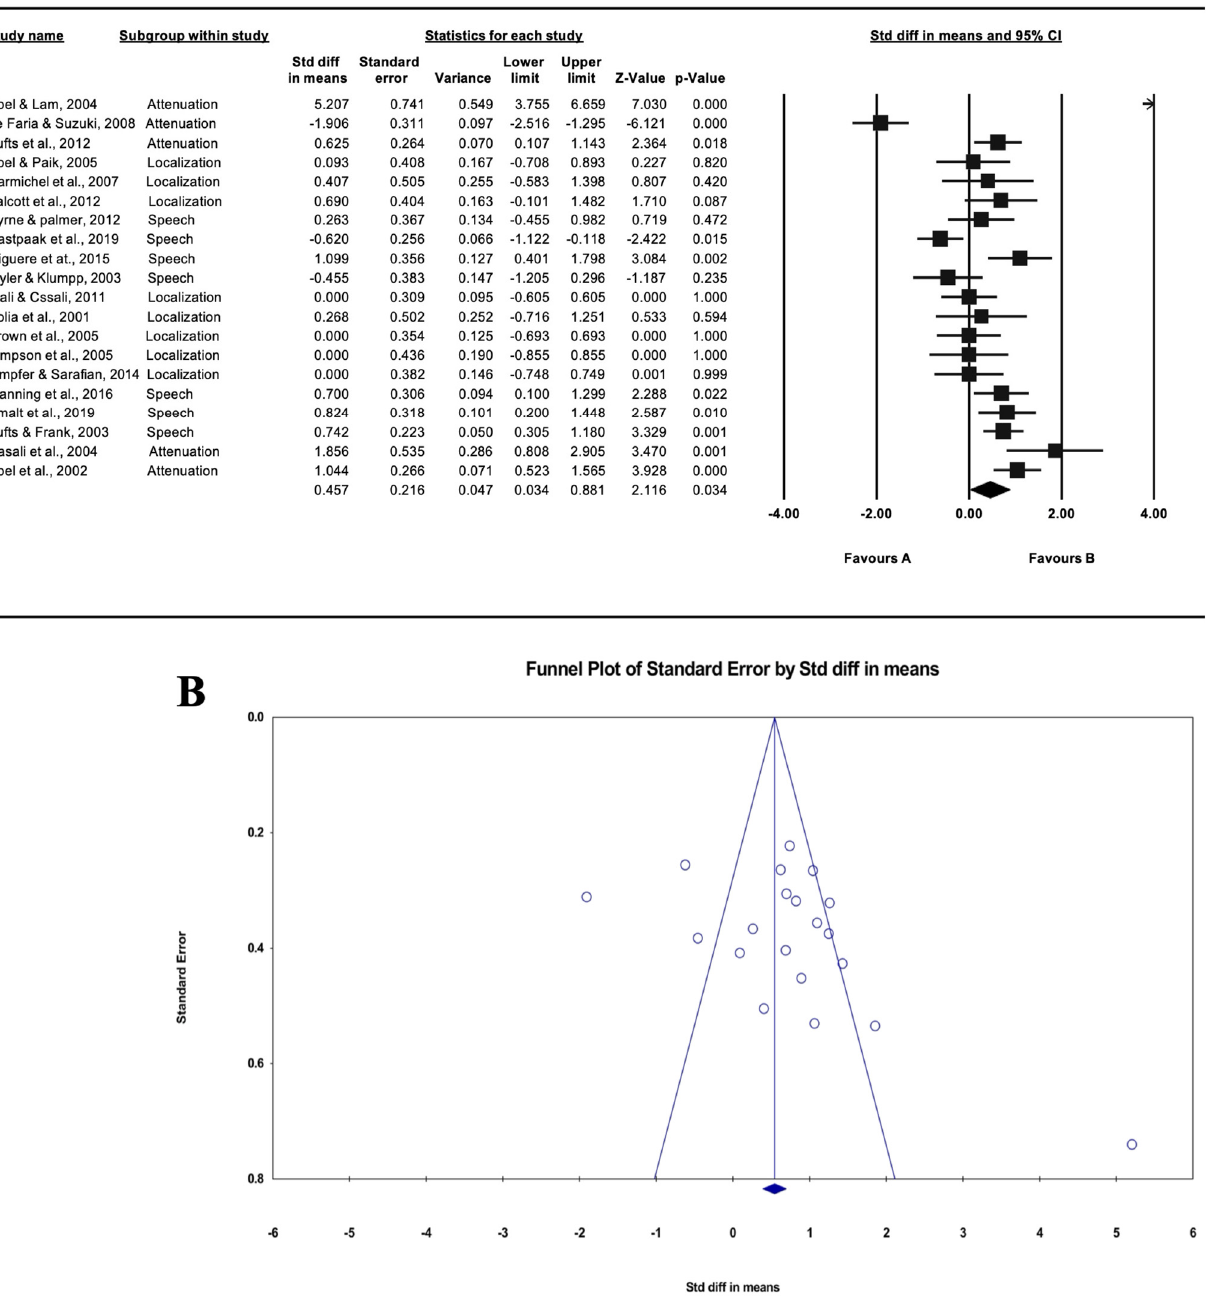
Figure 2. Forest plot of the twenty reviewed studies overall ( A ) and funnel plot of standard error for the standardized difference in means. Asymmetrical graph of funnel plot indicating publication bias ( B ).